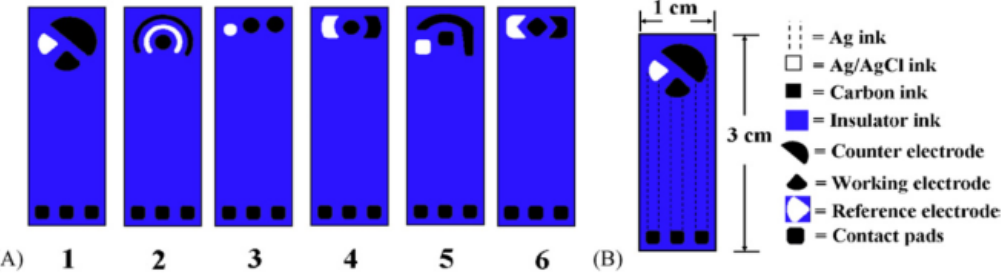
Figure 2. ( A ) Screen-printed sensor chip with six configurations; and ( B ) structure details for configuration 1. Reprinted from [60], with permission from Elsevier.